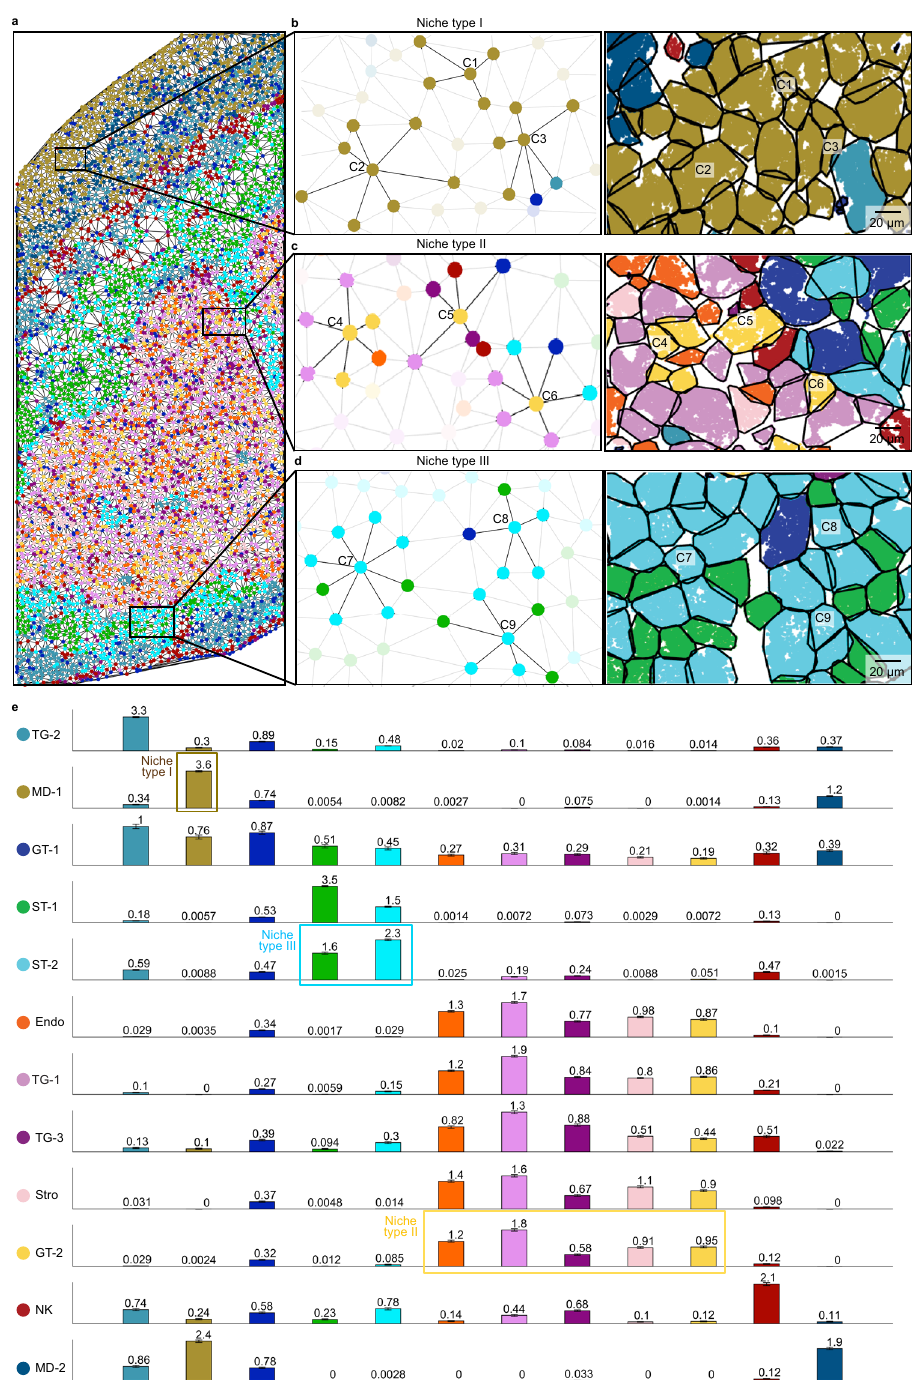
Fig. 4 ClusterMap reveals cell niche and cell – cell adjacency graph in the placenta. a Mesh graph generated by Delaunay triangulation 26 of cells shown in the STARmap mouse placenta 903-gene reveals cell niche. Each cell is represented by a spot in the color of its corresponding cell type. Physically neighboring cells are connected via edges. b – d A zoomed-in view of the top, middle, and bottom square in a . The intercellular connection is centered on three MD-1 type (C1, C2, C3), GT-2 type (C4, C5, C6), and ST-2 (C7, C8, C9) type cells, respectively, with their fi rst tier of neighboring cells highlighted. Left: schematic; right: cell segmentation map. e Bar plots of the average number of cells per cell type among the fi rst-tier neighbors, revealing clear patterns of cell-type speci fi c cell – cell communication. Cells in Niche Type I, II, and III show selective association with cell types highlighted in the corresponding bounding box. The cell types on the axes are denoted by initializes. Data are presented as mean values ±